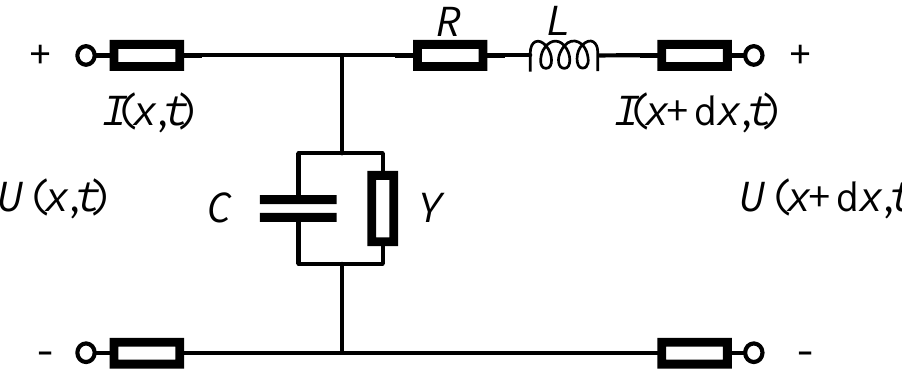
Figure 1. Classic power network branch equivalent circuit diagram.